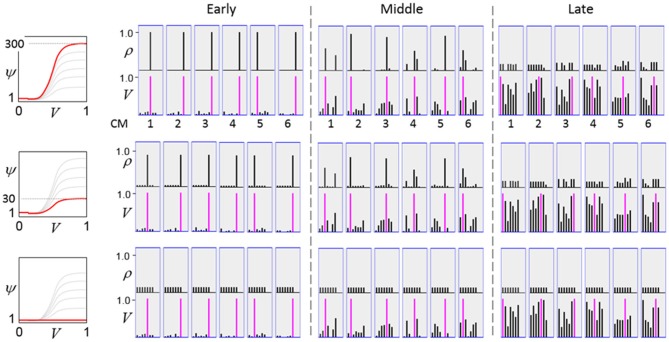
G-based sigmoid transform characteristics. All panels show hypothetical V and ρ vectors over the K = 7 cells in each of the Q = 6 CMs comprising the mac. In all nine panels, the V vector in each CM has one cell prescribed to have V = 1 (pink bars). The V's of the other six cells (black bars) in each CM are drawn randomly from defined intervals that depend on the age (amount of inputs experienced) of the model. For each age condition, we show the effects of using a V-to-ψ map with three different η-values. But our purpose here is just to show the consequences on the final ρ distribution for a given V distribution (the V distribution is the same for all three rows in any given column) as a function of the expansivity/compressivity (η) of the V-to-ψ map. See text for details.